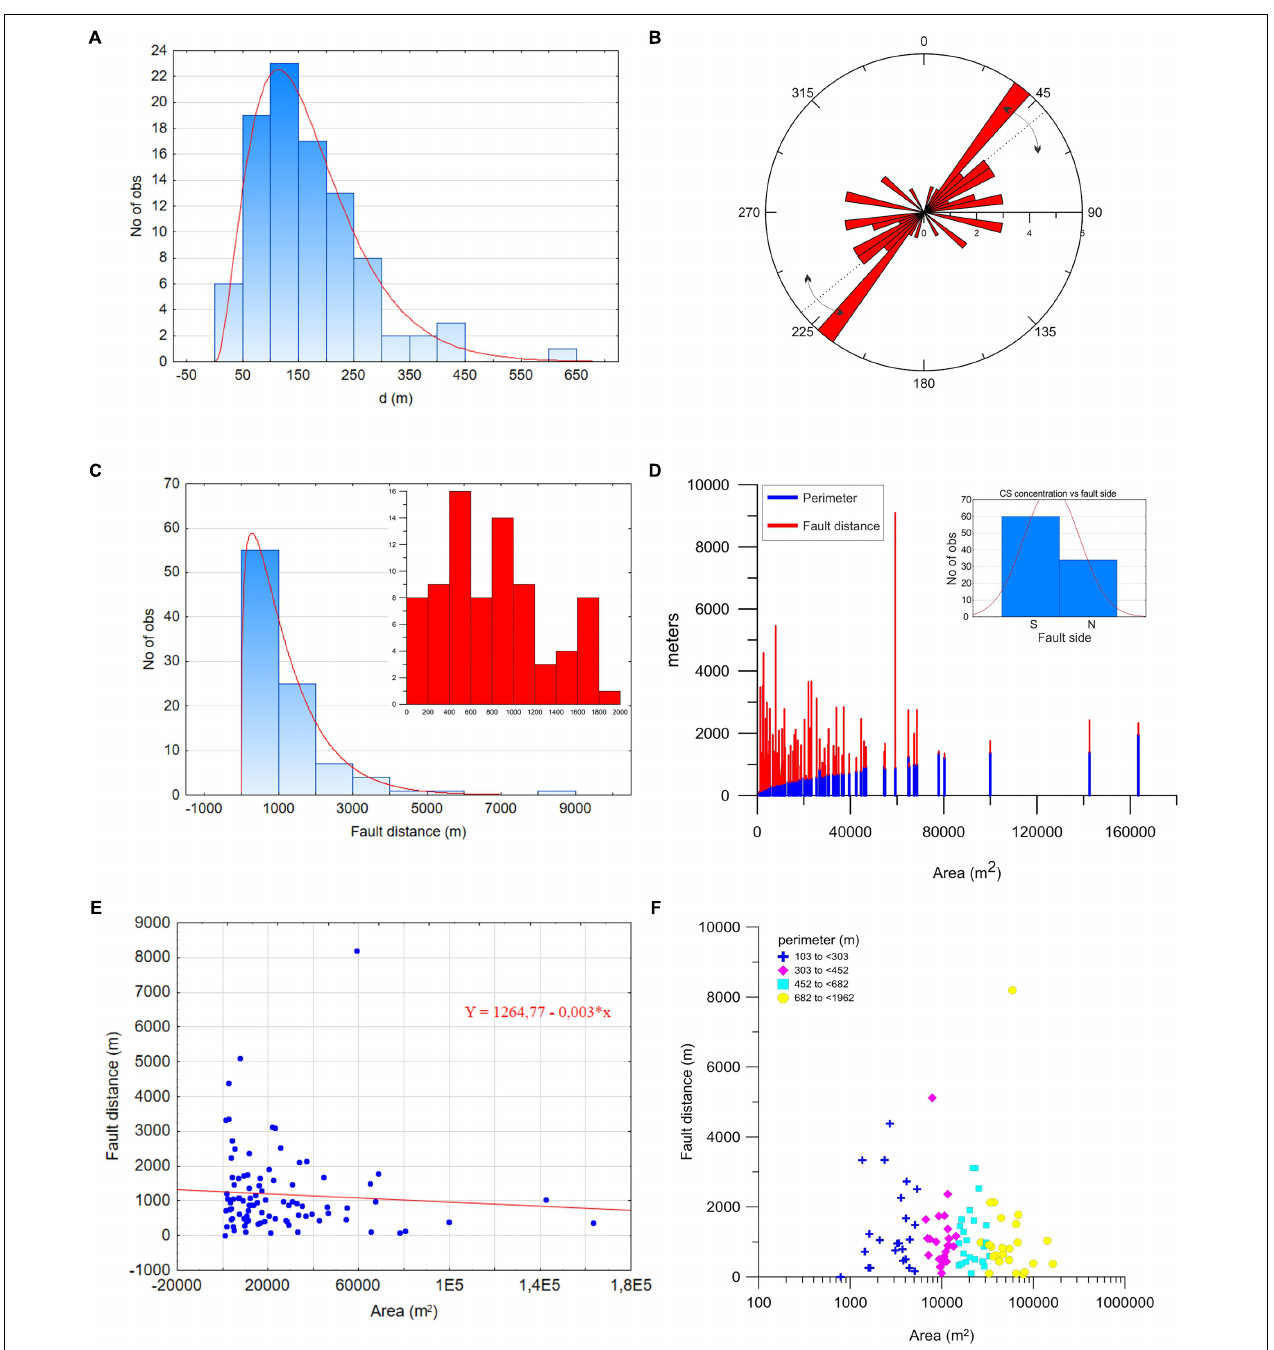
FIGURE 5 | Results of the statistical study of the mapped CS. (A) histogram and the corresponding fitted gamma distribution of the measured CS diameter showing that most of the structures (59 cases) have diameter ranging between 50 to 200 m, and the highest number of observations (23 cases) were recorded between 20 and 100 m in diameter; (B) Rose diagram indicates that the majority of the structures have an axis elongated in NE/SW direction, i.e., subparallel to the fault strike direction (indicated by dashed line as main orientation, and arrows as angle range variations); (C) histogram with corresponding fitted gamma distribution of CS fault distance; most of the data (55 cases) are at a distance of less than 1000 m, 25 cases are between 1000 and 2000 m, the remaining 14% is distributed between 3000 and 6000 m from the fault, and only 1 cases is found at a distance between 8000 and 9000 m. Inset shows in detail the first 2000 m of fault distance highlighting a bimodal distribution with most of CS ranging from 400–600 and 800–1000 m. (D) Histogram of frequency distribution of perimeter and distance from the fault in function of the CS area. The column heights are proportional to the class frequencies of both variables. Statistics suggest that both variables (fault distance and perimeter) are not stationary in the study area and that there are trends in the spatial distribution of data values. (E) Scatterplot of fault distance vs. area (m 2 ) helps to fit the function through the points to best represent the relationship between the two variables providing a linear fit equation. (F) The correlation among fault distance, perimeter, and area of CS highlights the presence of four perimeter population classes.